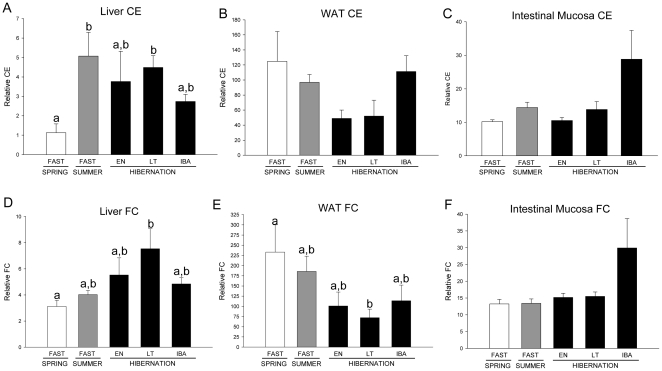
Tissue cholesterol levels in ground squirrels.Liver, white adipose tissue (WAT), and intestinal mucosa cholesteryl ester (CE) (A–C) and free cholesterol (FC) (D–E) levels in fasted spring (SPR) (open bars) and summer (SUM) (grey bars) squirrels, and in hibernators (filled bars) in entrance (EN), late torpor (LT), and interbout arousal (IBA) are shown. Groups with the same letter are not different. All values represent means ± s.e.m., n = 5 or 6 for all groups.